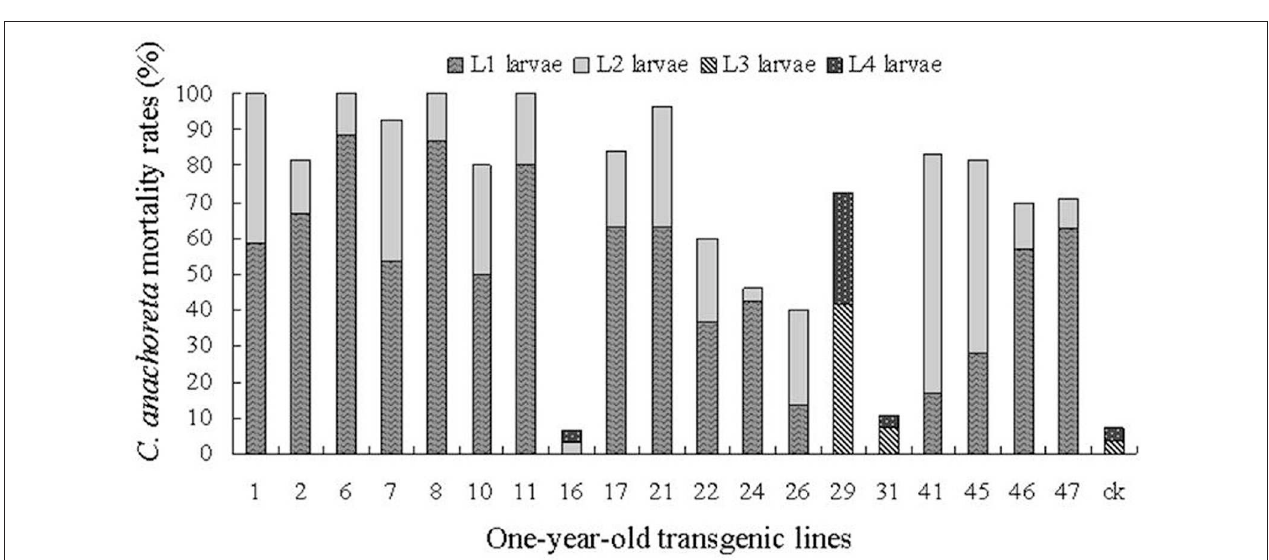
FIGURE 6 | C. anachoreta death distribution in different developmental stages of 1-year-old trees. Data are means of three replicates. This mortality is not corrected mortality. The larvae that fed on the leaves of 1-year-old trees were killed mostly during L 1 and L 2 . Few larvae survived to L 3 and L 4, and some larvae exhibited arrested body